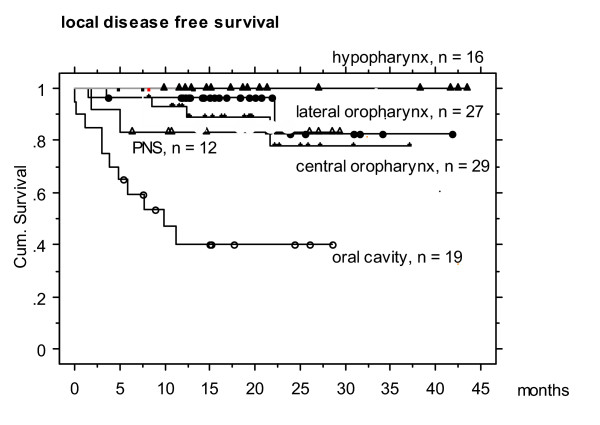
Actuarial 2 year local disease free survival in different HNC entities. Hypopharyngeal tumors revealed the highest local control rates, while oral cavity tumors showed the lowest rate. This fact can not be explained by TN stages or tumor volumes, and is issue of further data anaylses.